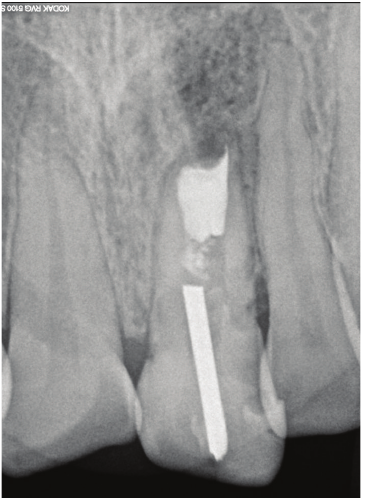
Figure 6: A follow-up radiograph at 52 months (4 years and 4 months) reveals complete healing of the initial periapical bone defect. At this time, the case was considered to be healed.